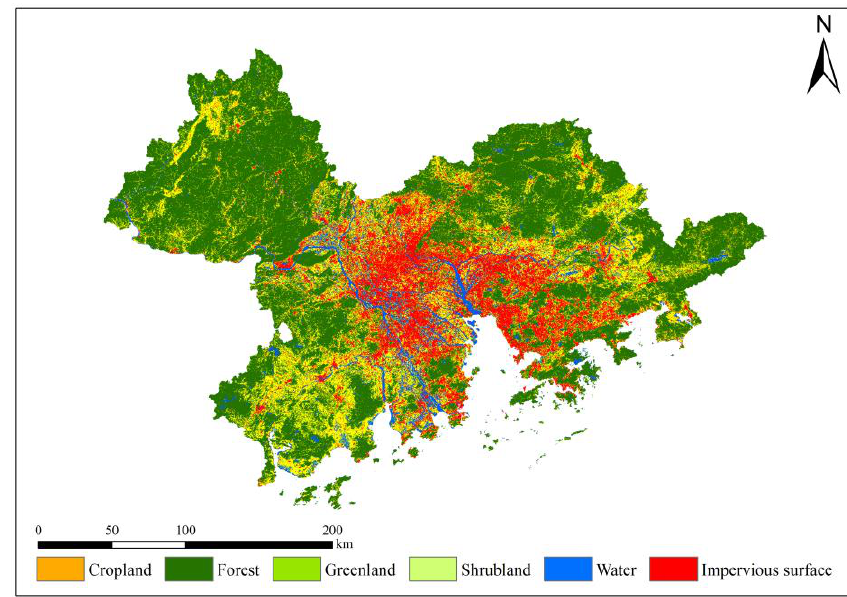
Figure 2. Land cover types in the GBA.